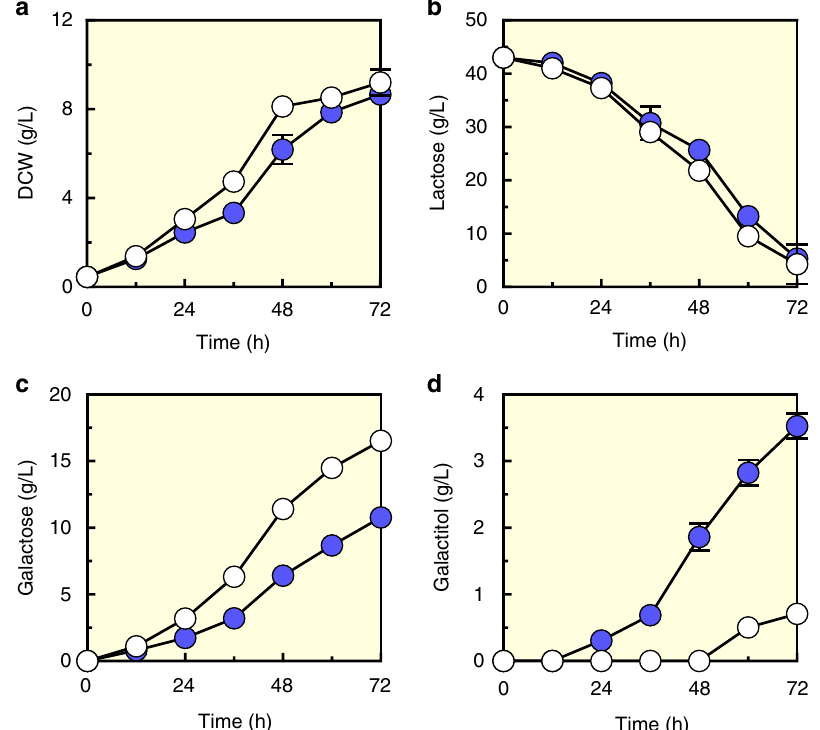
Fig. 2 Galactitol production after xylose reductase (XR) introduction into EJ2g. a Growth pro fi le as shown by dry cell weight (DCW), b lactose consumption, c galactose production, and d galactitol produciton by the EJ2g strain with XR overexpression in the pRS42K plasmid (EJ2g_pX, fi lled circles), and EJ2g with empty plasmid pRS42K as control (open circles) on YP medium with 40 g/L lactose under aerobic conditions. Data presented as mean values and standard deviations of three independent biological replicates. Source data are provided as a Source Data fi